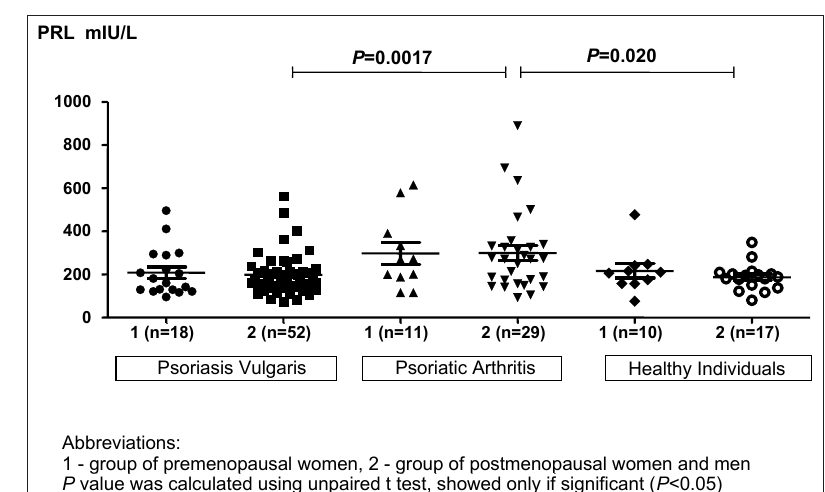
Fig. 2. Differences between serum prolactin (PRL) levels in premenopausal, post- menopausal women and men with Psoriasis Vulgaris, Psoriatic Arthritis and Healthy